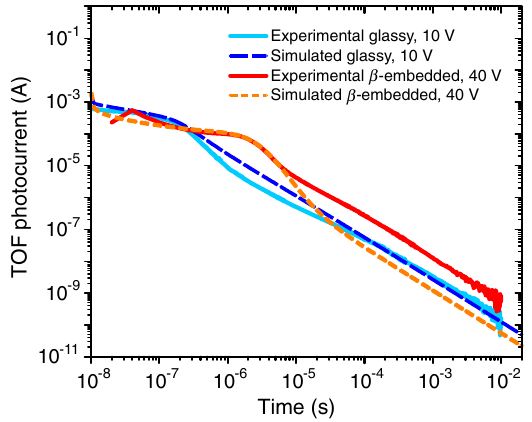
FIG. 9. Simulated (dashed lines) and experimental (solid lines) HDR TOF transients for glassy (blue) and β -phase embedded (red) HMW PFO devices at RT. The experimental traces are reproduced from Fig. 5(a). The model reproduces positions of transient features and trends for both device types. The β -phase is introduced by adding a Gaussian sub-bandgap state as depicted in Fig. 8 and with no other parameter changed relative to the glassy case. Note that the transients are taken at different applied biases for the two